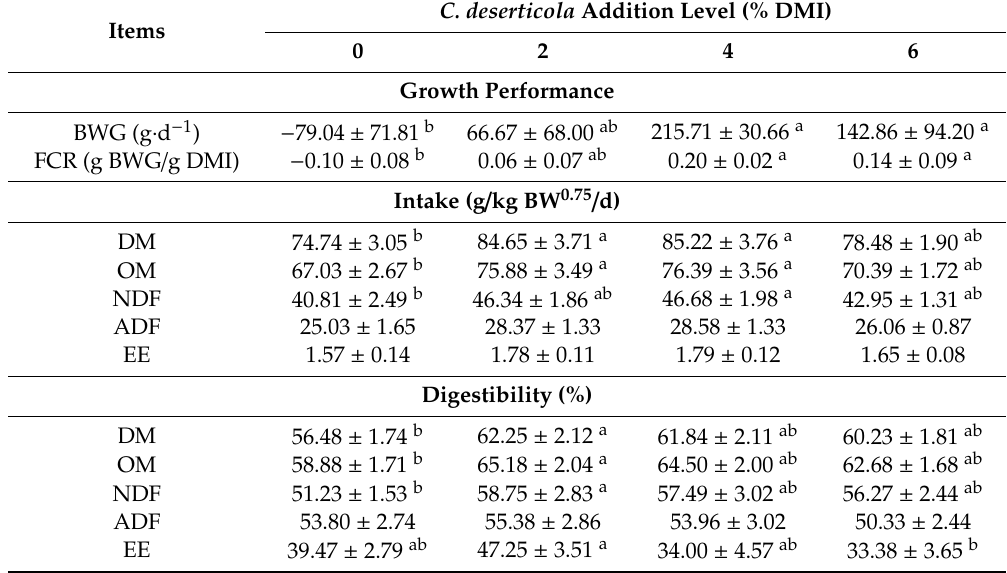
Table 2. E ff ect of C. deserticola addition on growth performance, intake, and digestibility (mean ± SE).